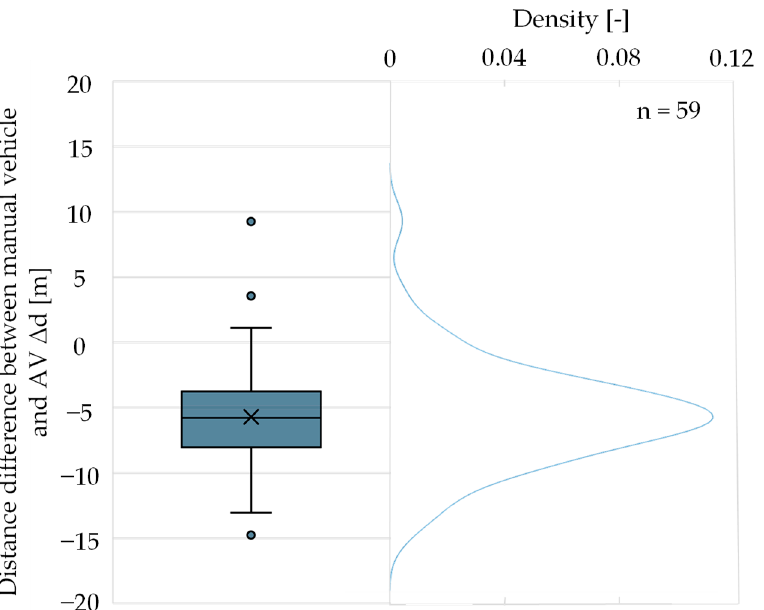
Figure 13. Distance differences and its relative frequency of the manual vehicles and AVs when one of them has already reached the interaction phase. Negative values mean that the manual vehicle arrived at the road bottleneck first.